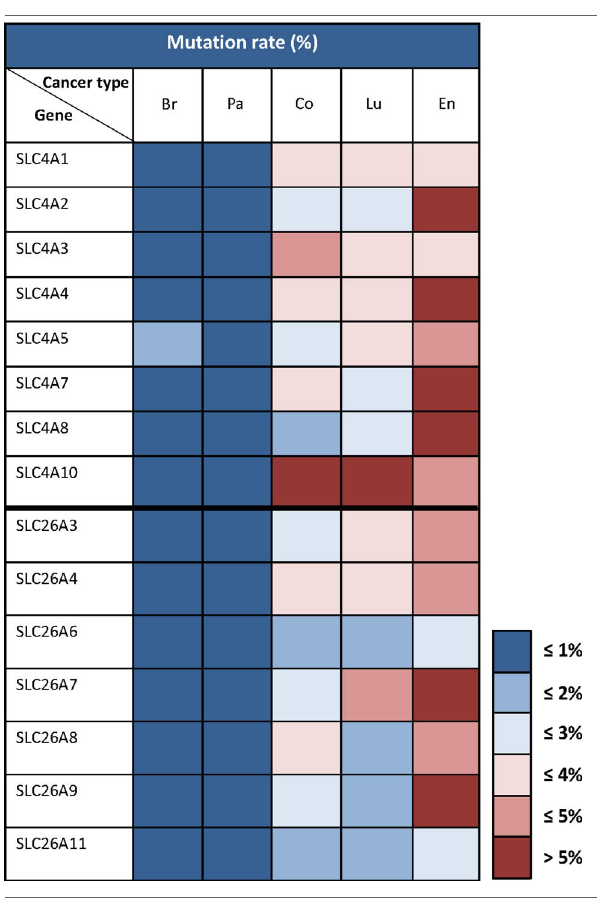
Table 2 | Somatic mutation rates for SLC4 and SLC26 family transporters in different cancer